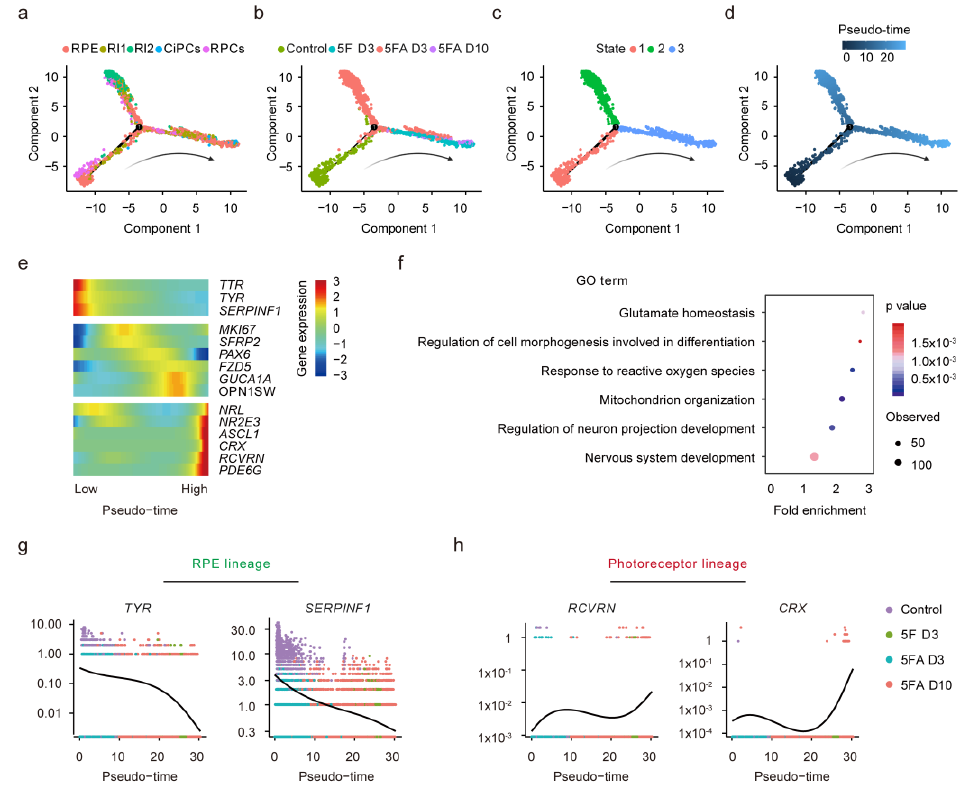
Figure 6. Trajectory and pseudo-time analysis identify dynamic changes along with the commit-ment to CiPCs. ( a – d ) Single-cell pseudo-time trajectory analysis using Monocle2. Cells on the tree are colored by cell type ( a ), treatment condition ( b ), state ( c ), and pseudo-time ( d ). The arrangement of cells on the trajectory from left to right (arrow) reveals the epithelium to retinal neuron transition. Cell states ( c ) are calculated by Monocle2 based on their pseudo-time values. ( e ) Heatmap of genes showing significant differential in pseudo-time-dependent expression. ( f ) GO analysis of genes showing significant differential pseudo-time-dependent expression. ( g ) Kinetic curves for RPE lineage genes TYR and SERPINF1 . ( h ) Kinetic curves for photoreceptor lineage genes RCVRN and CRX